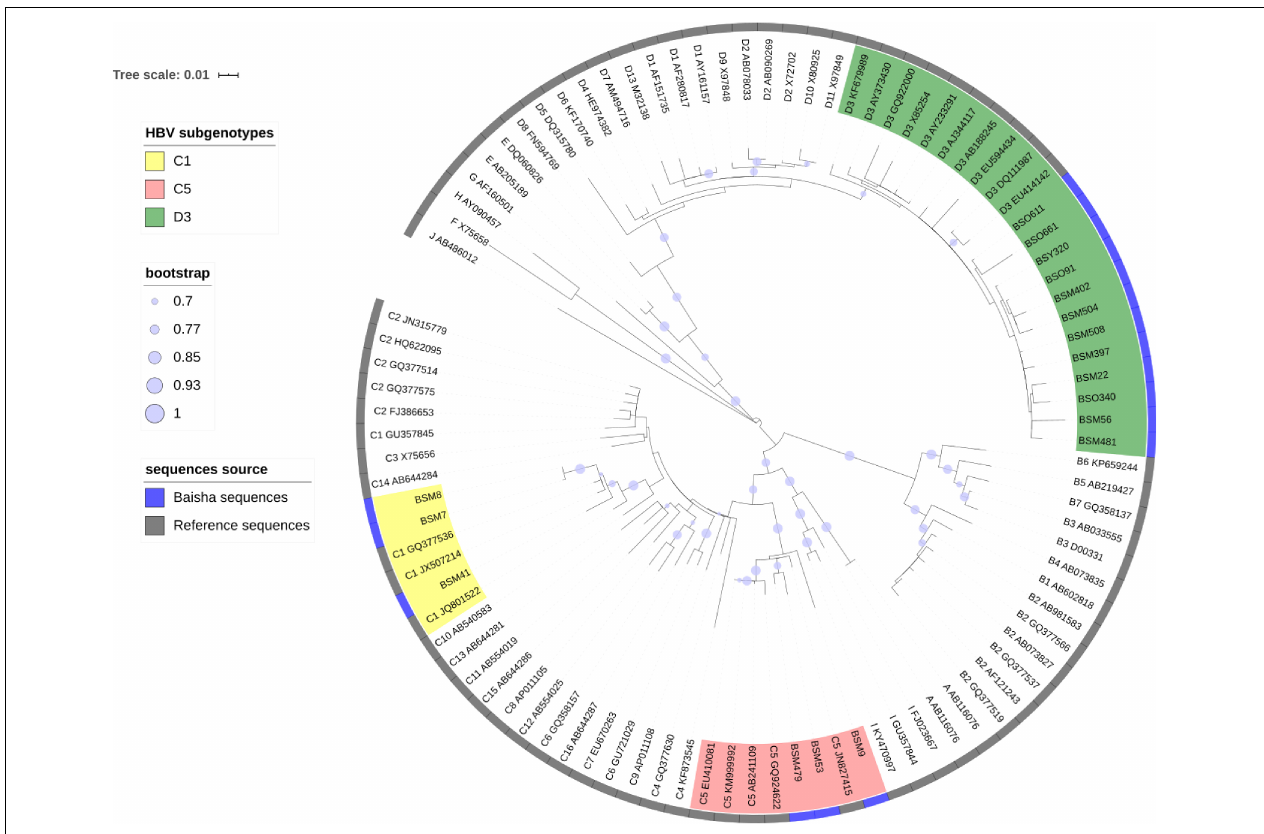
FIGURE 2 | Estimated maximum-likelihood phylogeny for Baisha’s Li ethnic part of Pre-S/S region(1b) sequences. The sequences determined in this study are shown in a blue strip. Reference sequences were named by subgenotype, and accession numbers represent the assigned HBV genotypes and